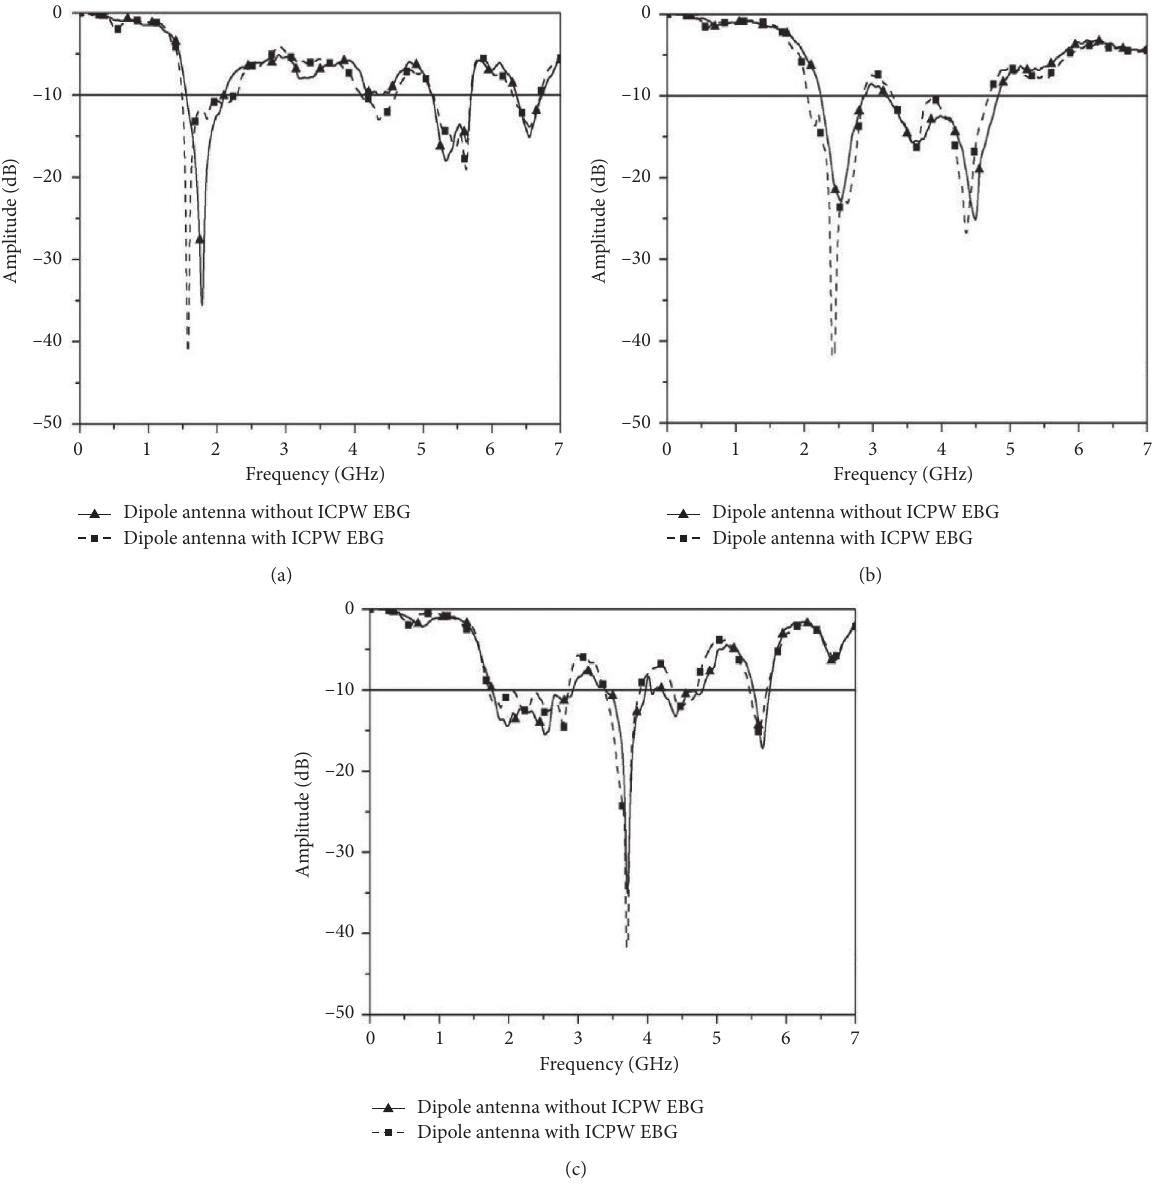
Figure 17: The S11 measurement results of dipole antenna with ICPW-EBG: (a) 1.8GHz, (b) 2.45GHz, and (c)